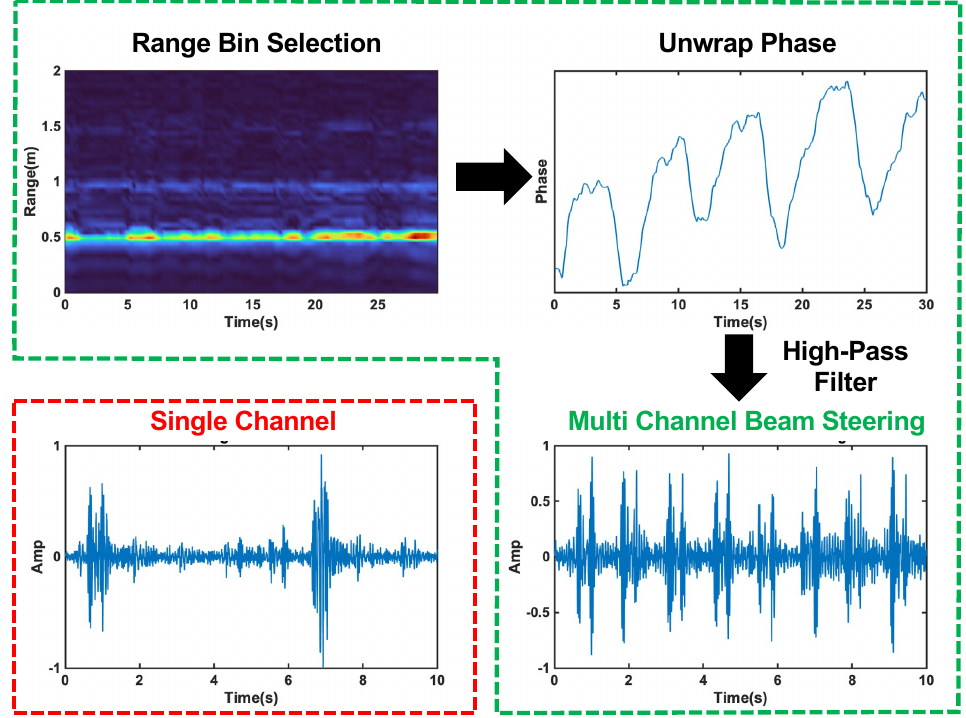
Figure 8. Radar signal processing steps with beam forming circled in green. The top left plot shows the range profile used for range bin selection. The top left plot displays the unwrapped phase of the signal at the selected range bin. The bottom right plots show the final heart sound signal after high − pass filtering for the multi − channel beam steering case, and the single − channel case is circled in red in the bottom left plot. The beam steering clearly captures each heart sound cycle, while the single − channel signal is distorted and misses many